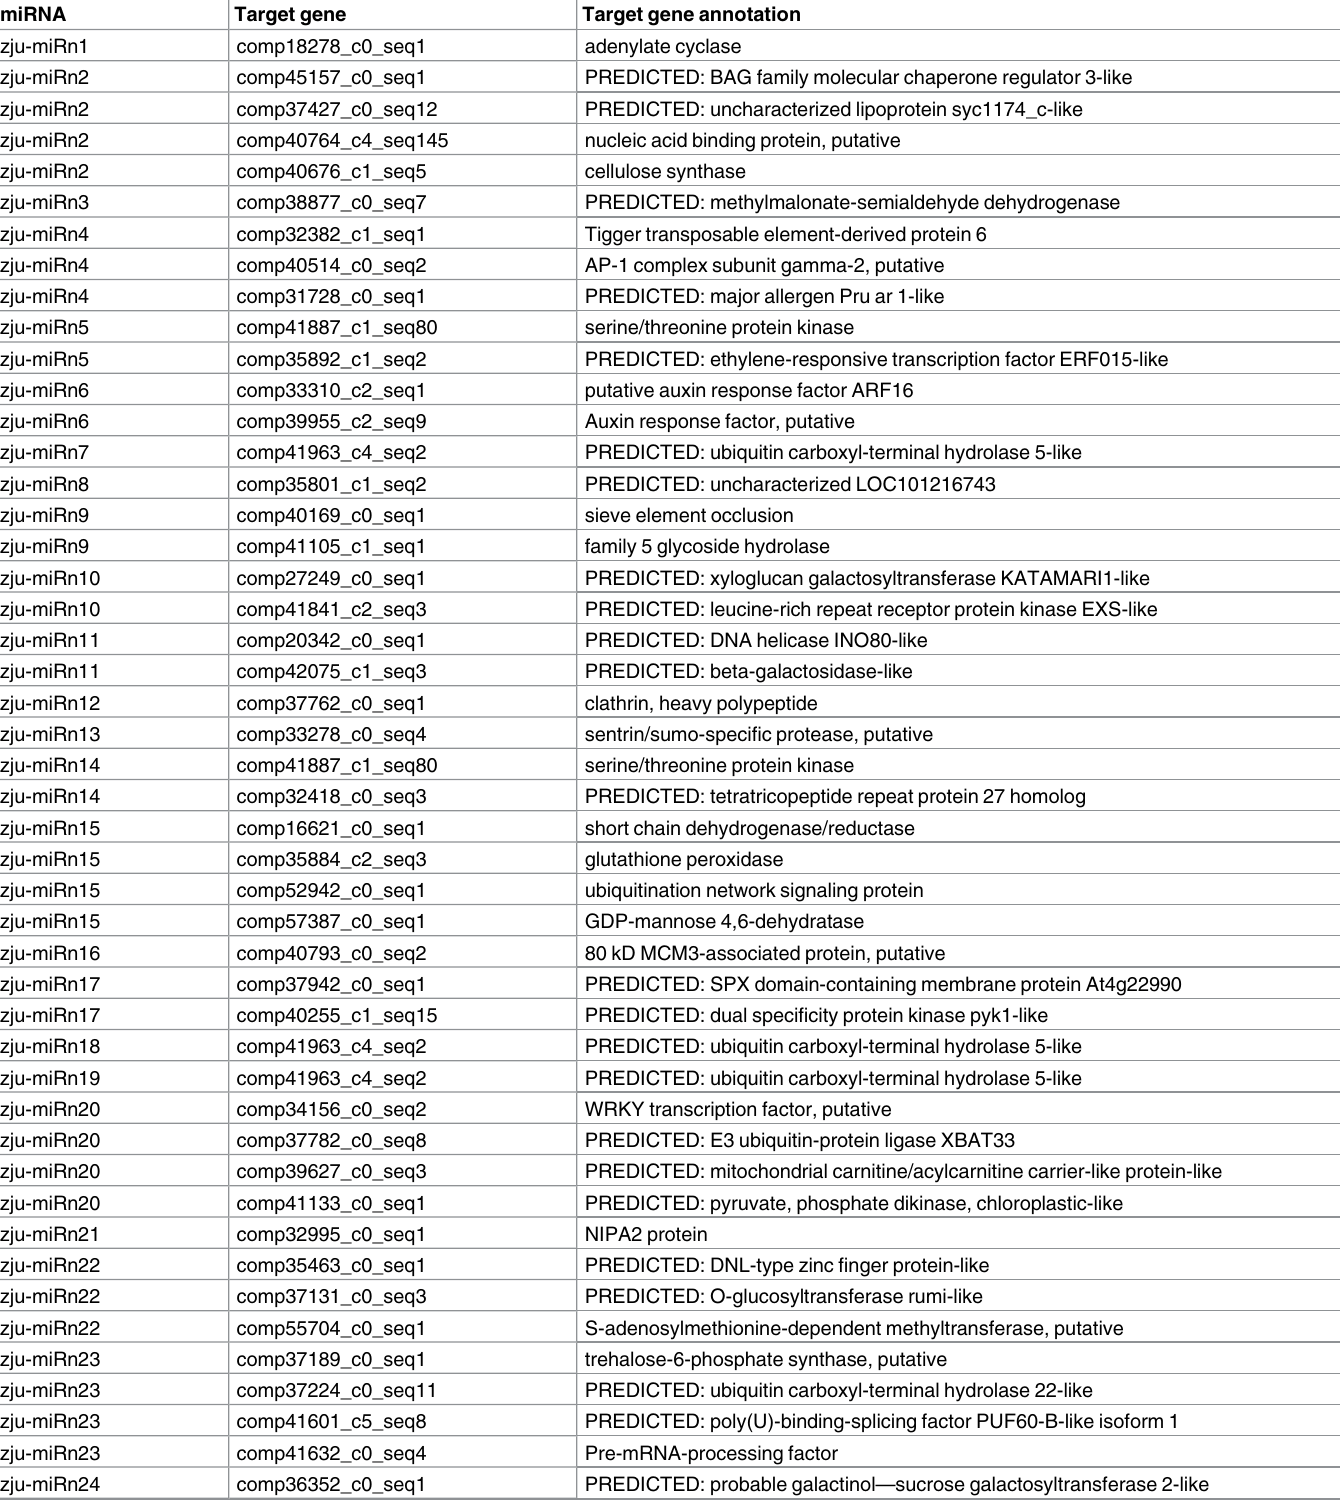
Table 5. The predicted novel miRNAs targets of Z . jujuba